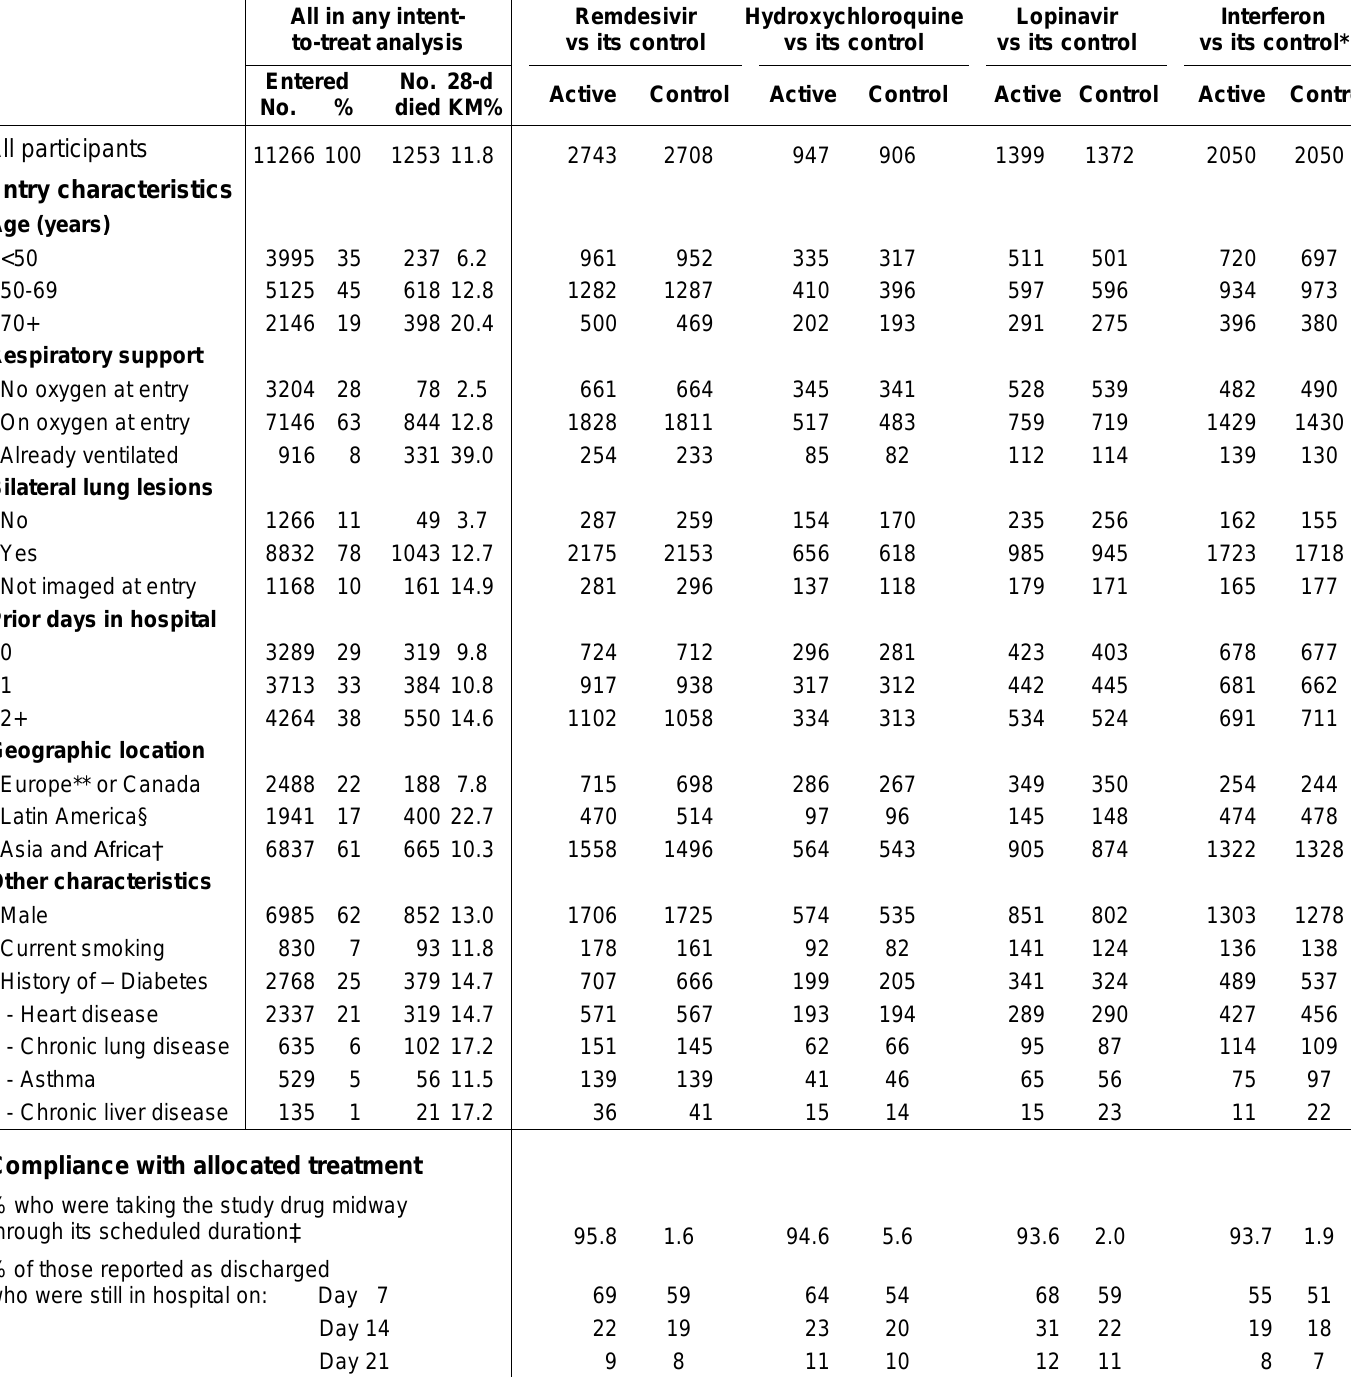
Table 1. Entry characteristics by random allocation, and compliance with that allocation Excludes 64 without clear consent to follow-up. Comparisons are of each study drug vs concurrent allocation to the same